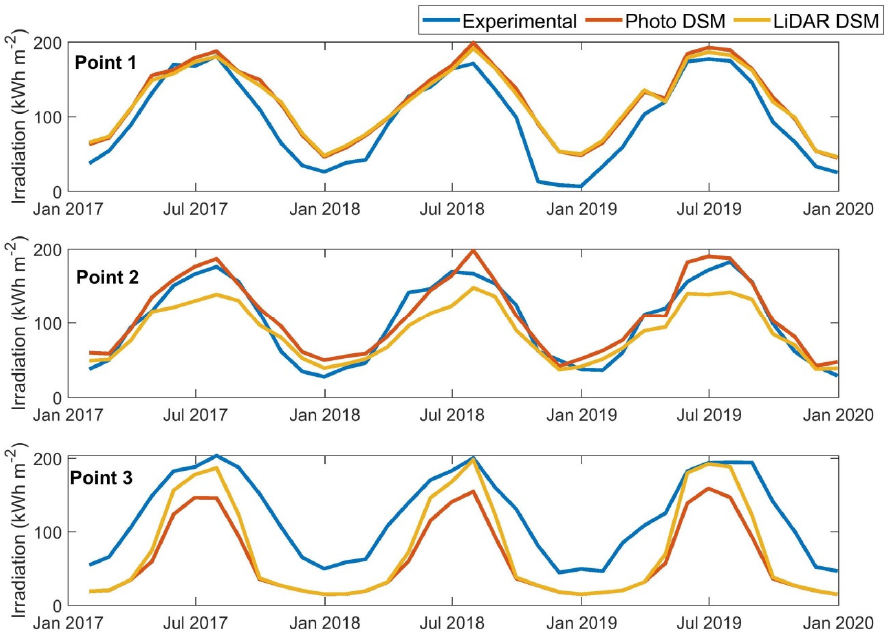
Figure 8. Assessment of monthly horizontal irradiation.